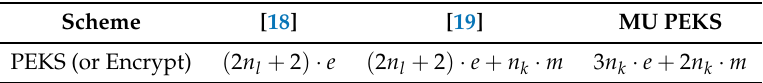
Table 6. The comparison of sensors’ computation complexity.